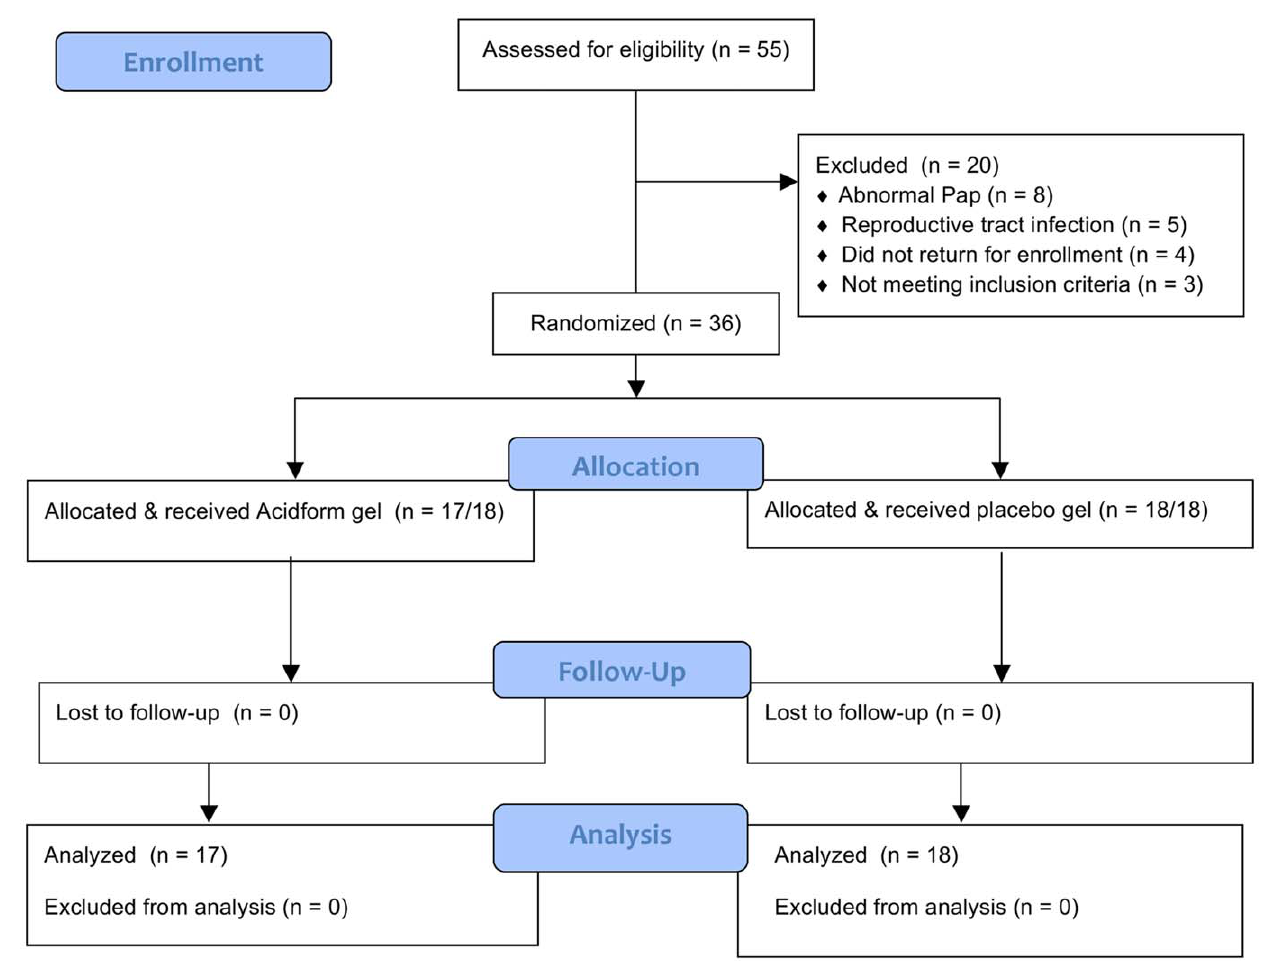
Figure 1. Trial profile.